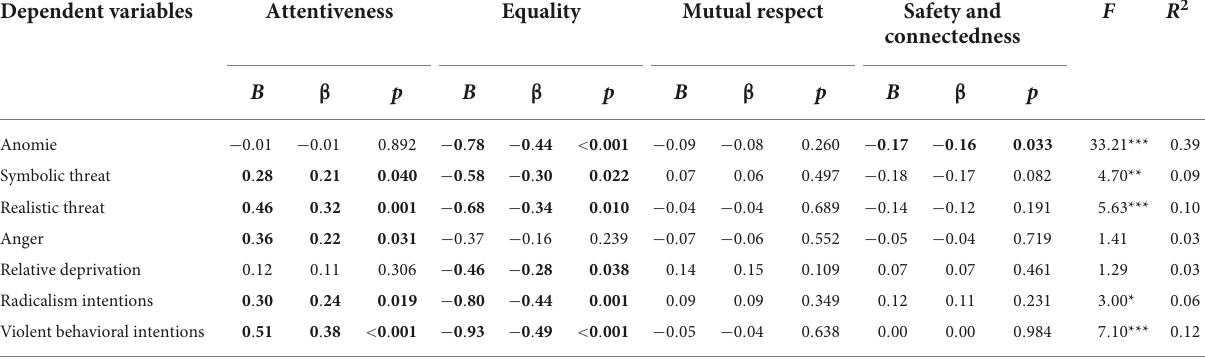
TABLE 3 Linear regression analyses with equality, attentiveness, mutual respect, and safety and connectedness as predictors. Dependent variables Attentiveness Equality Mutual